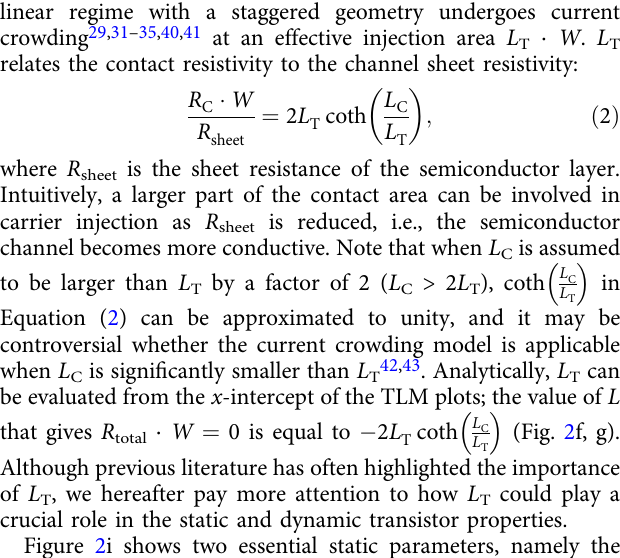
Fig. 3d, the current gain decreases with increasing f , following − 20 dB dec − 1 (represented as a black line in Fig. 3d), which is consistent with the conventional model expected for FETs; the observation of a decay slope of − 20 dB dec − 1 , equivalent to f − 1